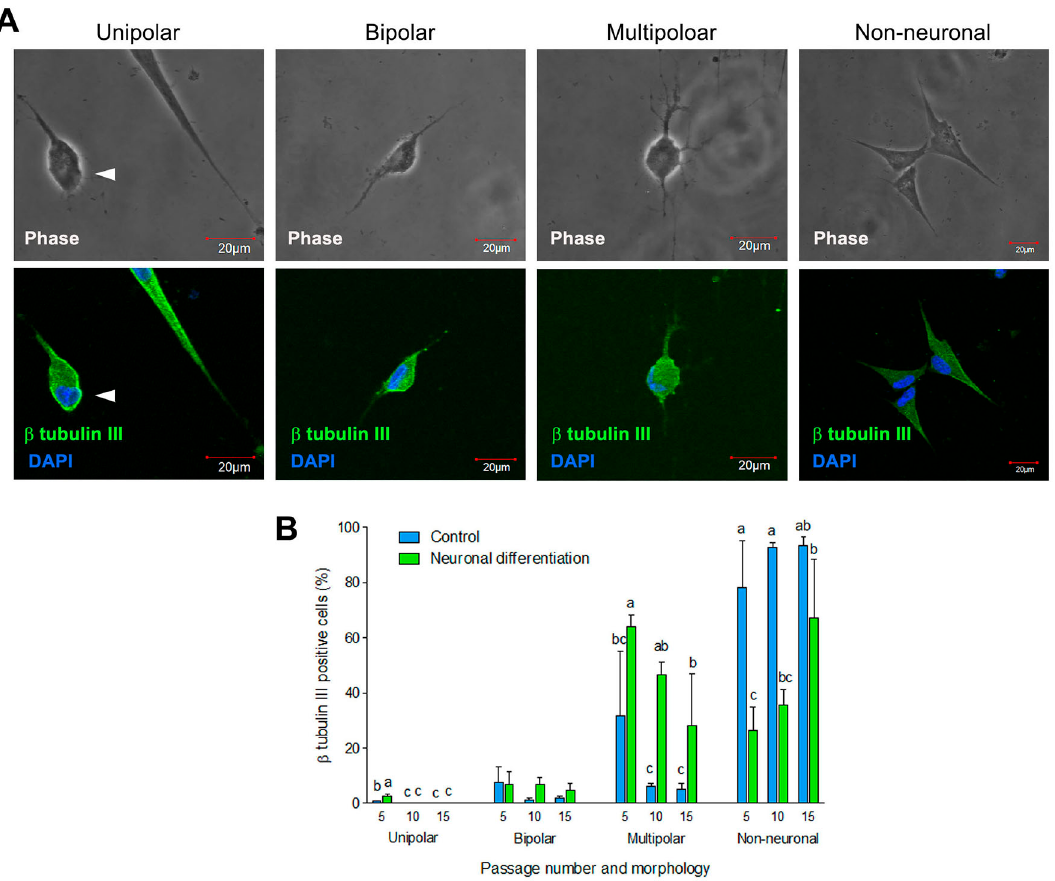
Figure 6- Effect of passage number of DPSCs on neuronal morphological change after cultured the cells in neuronal differentiation medium compared to control medium. (A) Unipolar (arrowhead), bipolar, multipolar, and non-neuronal morphology observed in the β-III tubulin-expressing cells. The upper panel is phase contrast images and the lower panel is immunofluorescence images; green: β-tubulin III; blue: DAPI. (B) Percentage of β-tubulin III-expressing cells that exhibit each type of neuronal morphology. Bars with different alphabets are significantly different